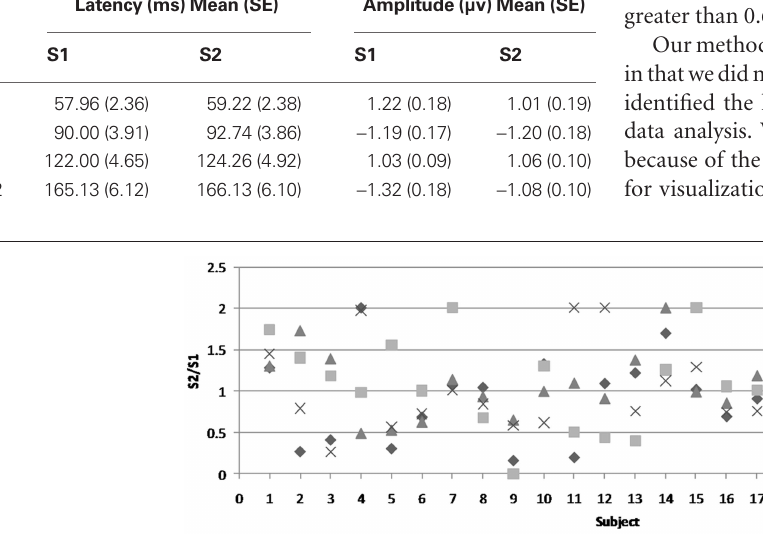
Figure 3 | gating ratios of each peak for all individual subjects. The figure legend is on the right-hand side. Each shape represents one of the four